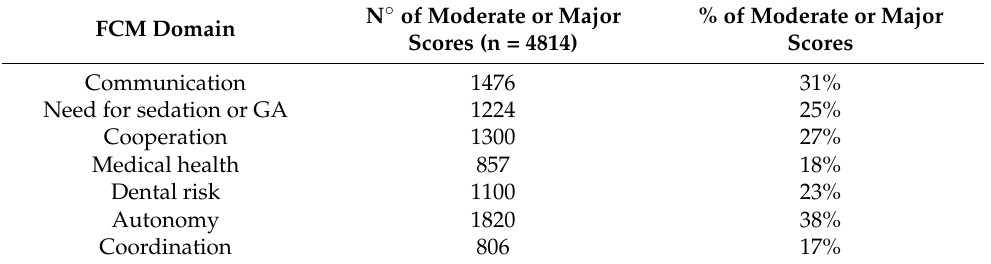
Table 3. Distribution of moderate or major FCM scores.